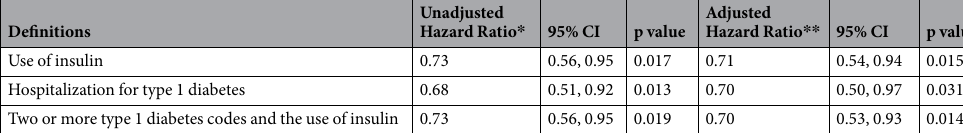
Table 4. Sensitivity Analysis for the Association between Rotavirus Vaccination and Type 1 Diabetes, 2006– 2017, using Different Methods of Detection. * Completed the entire rotavirus vaccination series versus no rotavirus vaccination. ** Adjusted for sex, season of birth, birth year, and region of the United